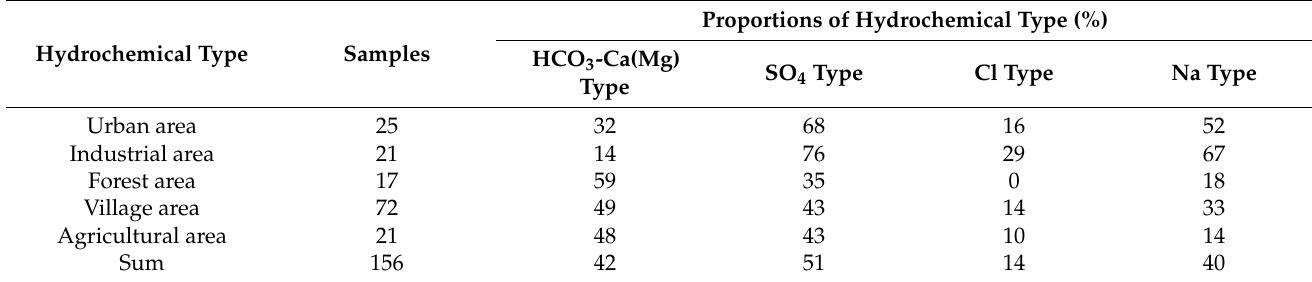
Table 3. Statistic table of groundwater hydrochemistry type of different land use in this